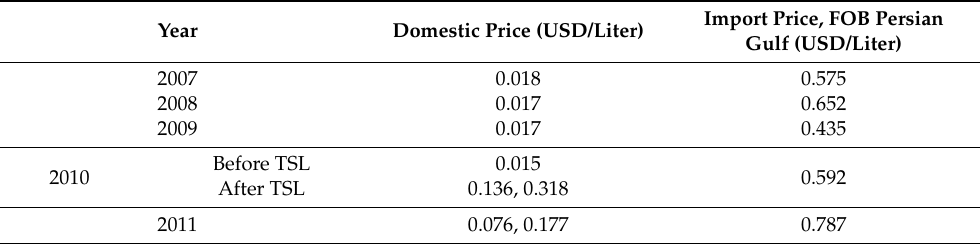
Table 3. Domestic and import prices of diesel in Iran,